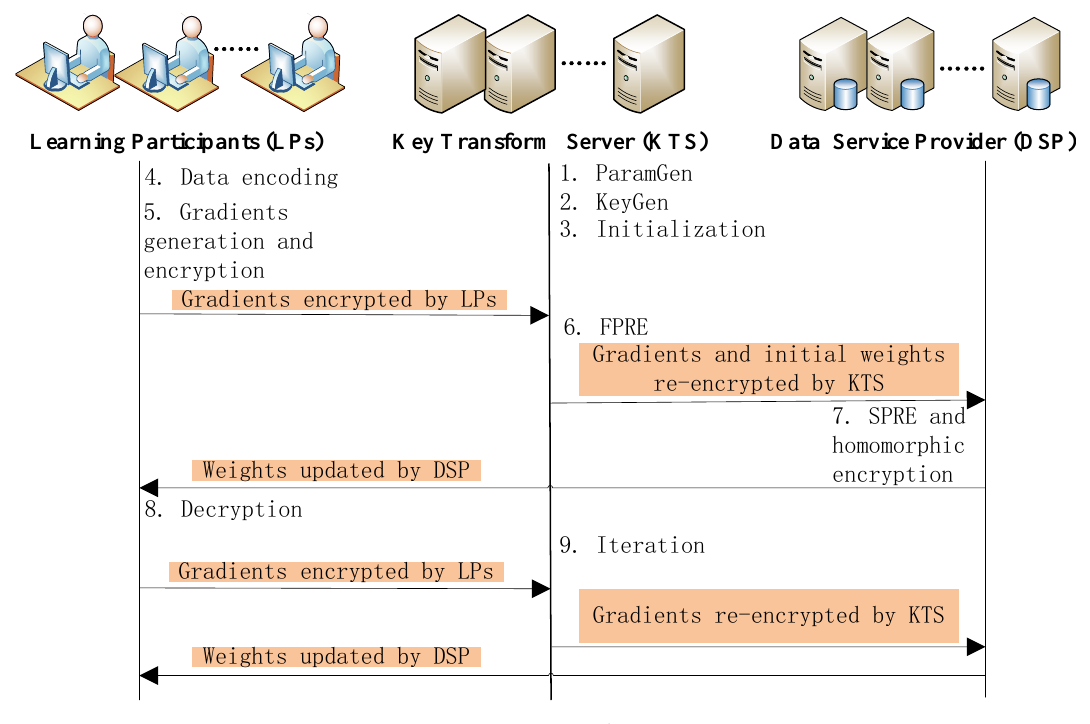
Figure 3. System